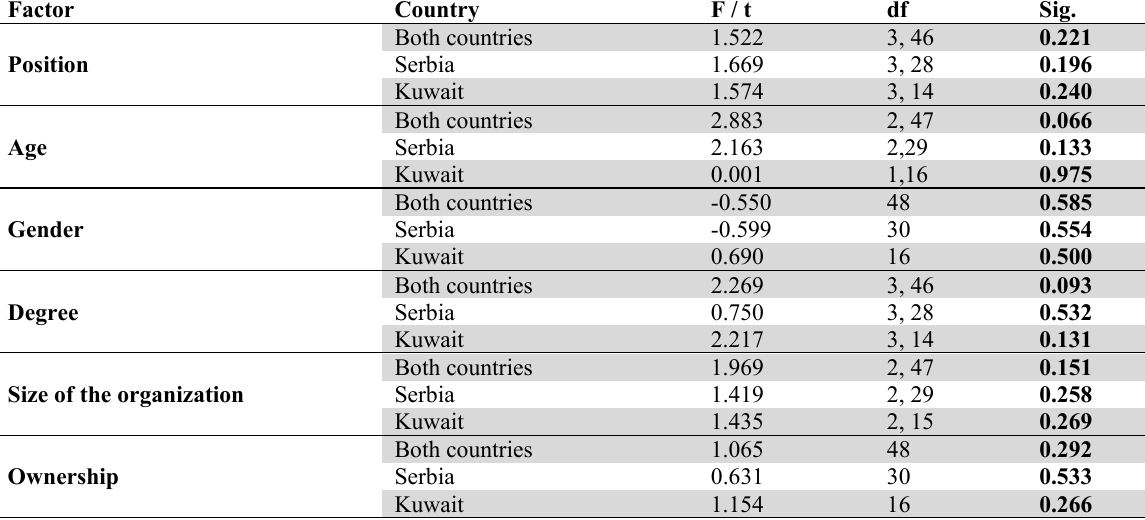
ANOVA and t-tests for the various